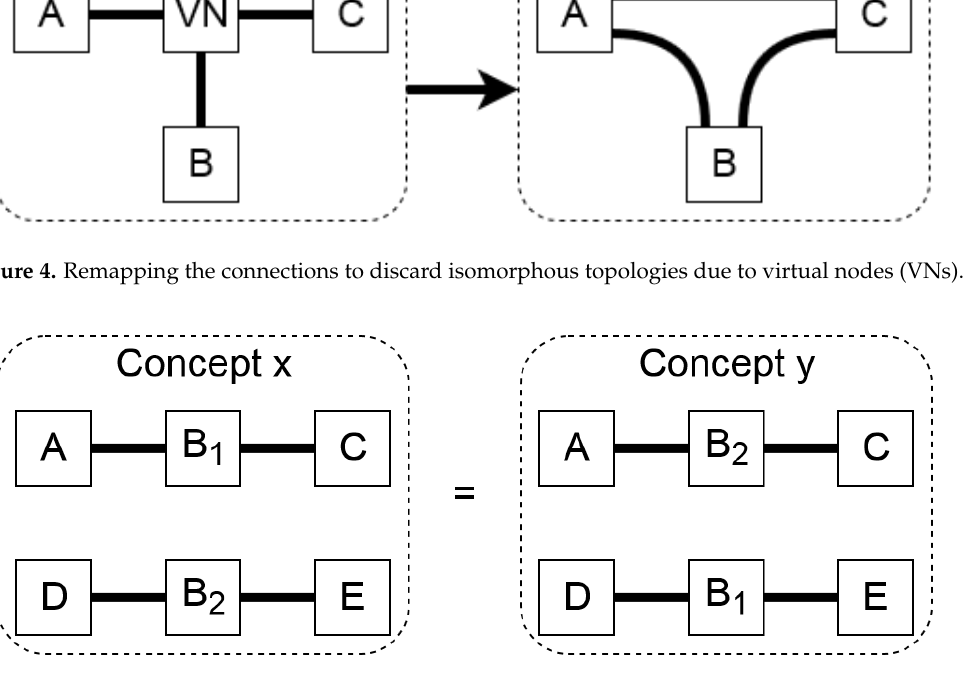
Figure 5. Two isomorphous topologies introduced by different component identifiers for multiple instances of a